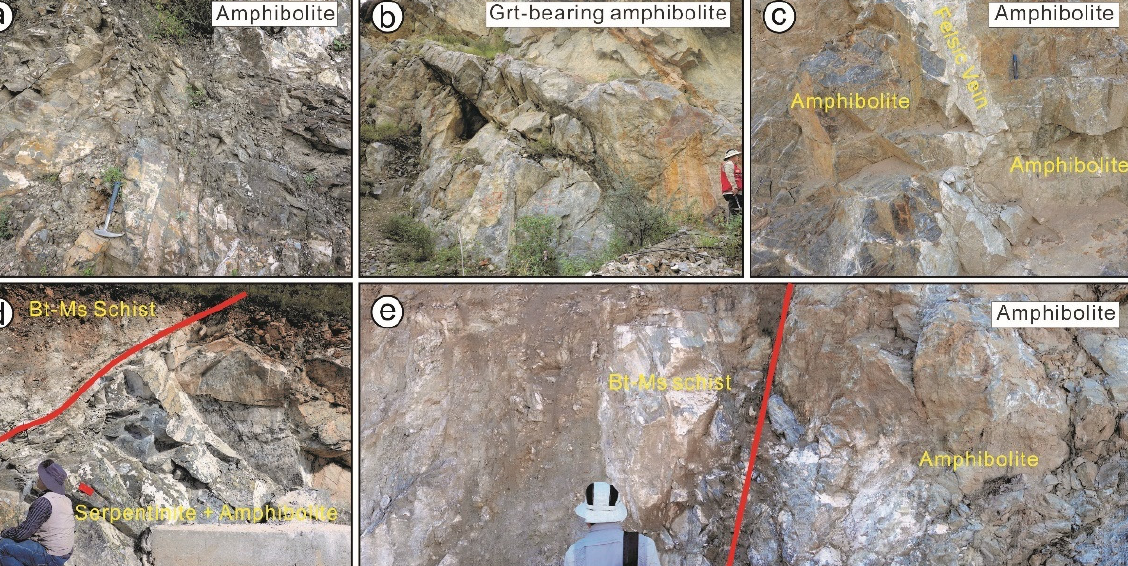
Figure 2. ( a – h ) Field photographs and ( i – q ) photomicrographs of mafic and metamafic rocks in the JASB. ( a ) Amphibolite in the Batang area; ( b ) Bedded Grt-bearing amphibolite in the Batang area; ( c ) Amphibolite intruded by felsic vein in the Batang area; ( d ) Amphibolite is accompanied by ser- pentinite and in contact with Bt-Ms schist by the fault in the Batang area; ( e ) Amphibolite is in sharp contact with Bt-Ms schist by the fault in the Batang area; ( f ) Pillow basalt in the Yaxuanqiao area;